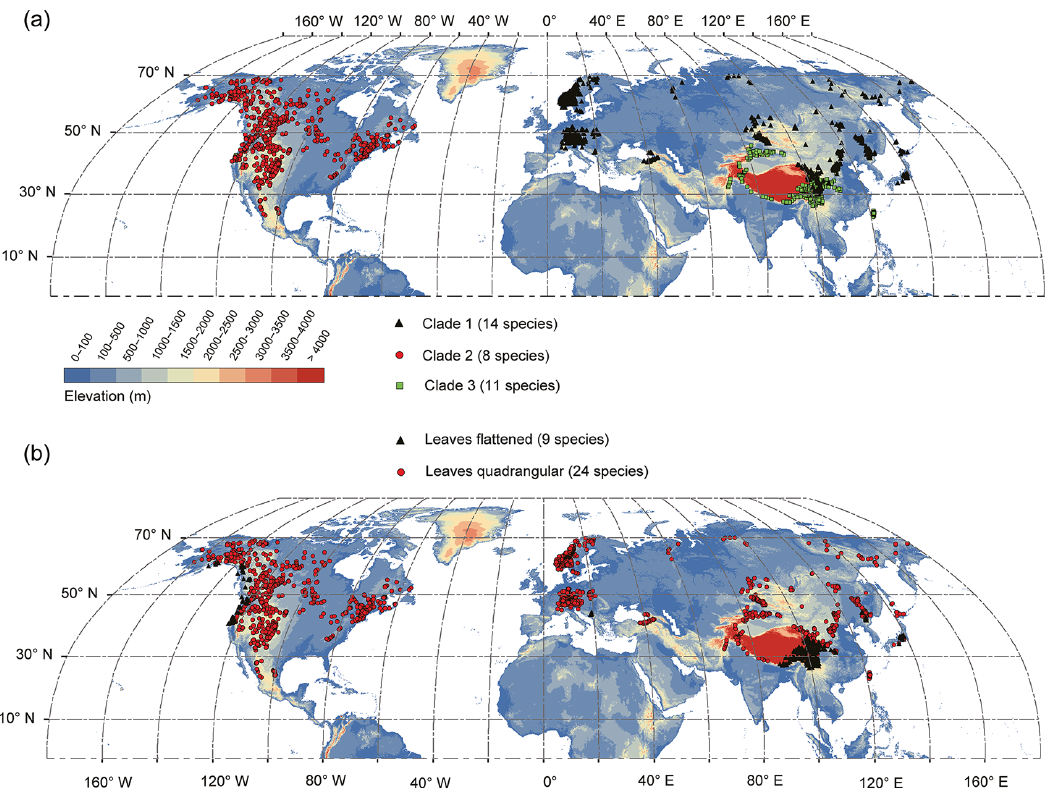
Figure 1. Sites were sampled across the entire range of spruces worldwide. Sites marked with different symbols represent three phylogenet- ically distinct clades (a) and two morphological groups (b) . Elevation gradients are indicated by colored